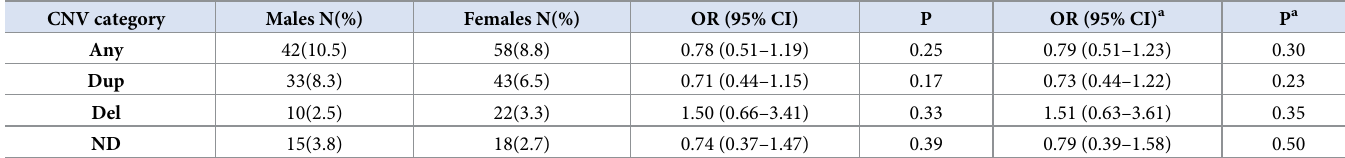
Table 3. Association of copy number variants with sex of individuals diagnosed with anxiety/depression in NCMH individuals. CNV